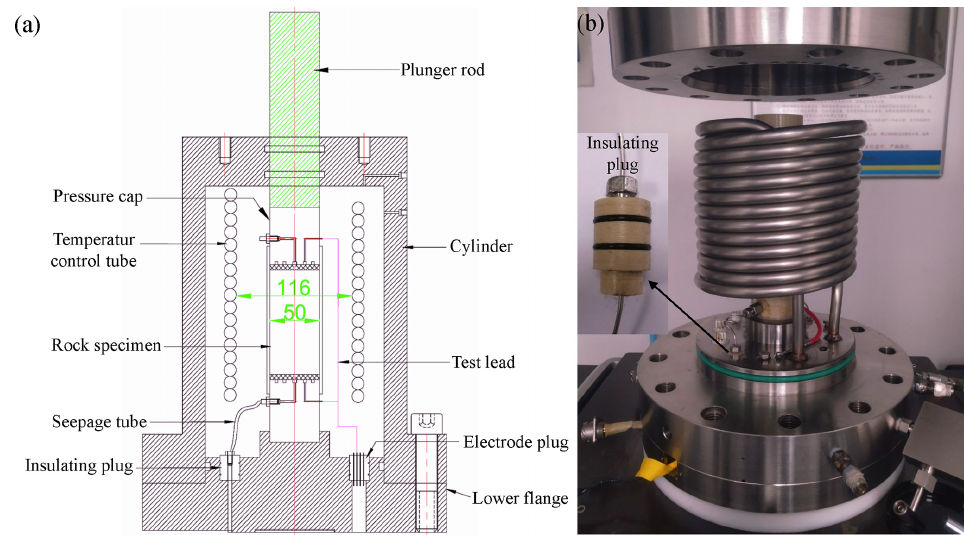
Figure 2. Triaxial pressure cell. (a) Design drawing. (b) Equipment.